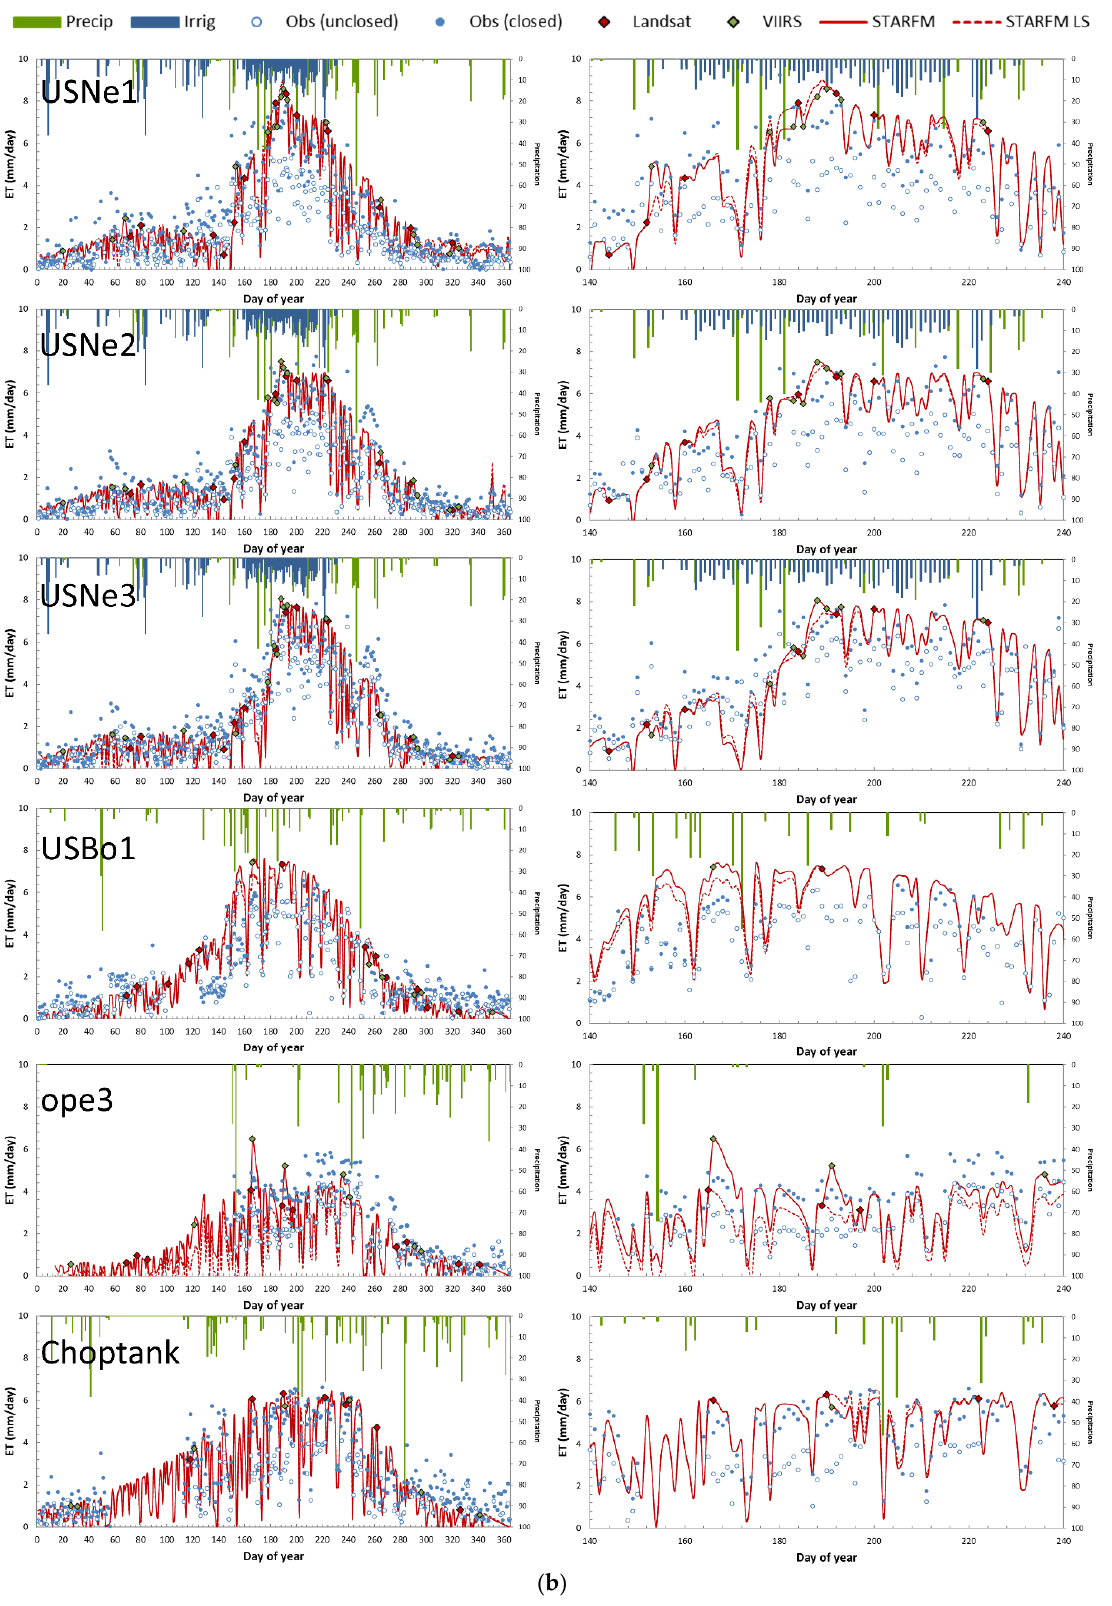
Figure 7. ( a ). Model-measurement time-series intercomparison at the CA flux tower sites for the full year of 2018 (left) and peak growing season (DOY 140–240; right). ( b ). Model-measurement time-series intercomparison at the MD, IL and NE flux tower sites for the full year of 2018 (left) and peak growing season (DOY 140–240;